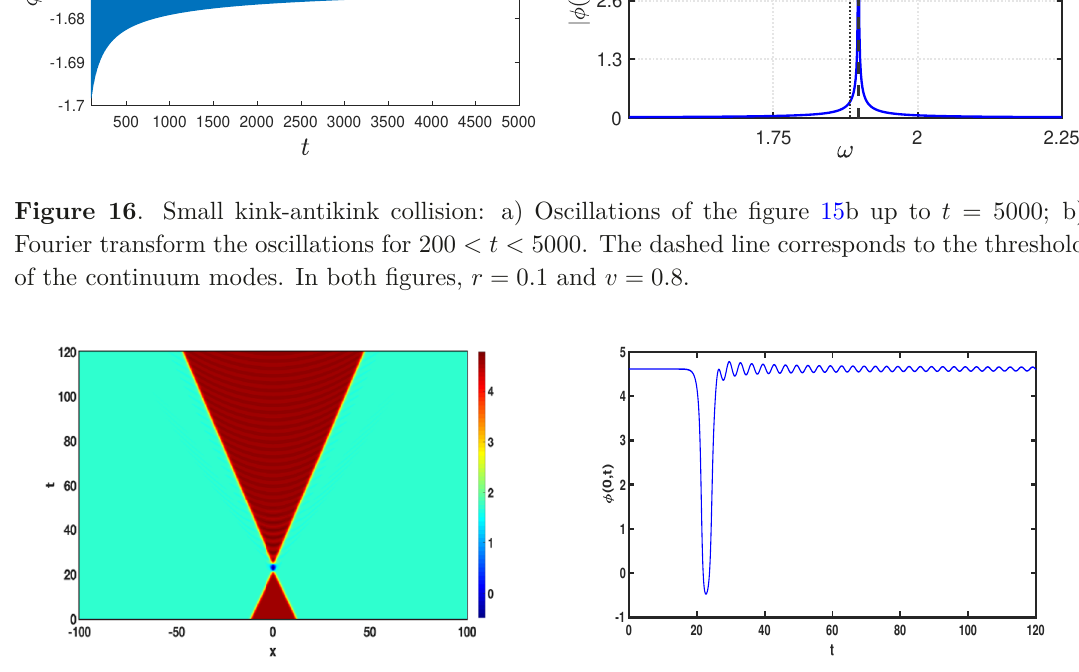
Figure 17 . Small kink-antikink collision, showing one bounce: r = 0 . 1, v = 0 . 55. amplitude A of the field at x = 0 follows the decay expression Merabet